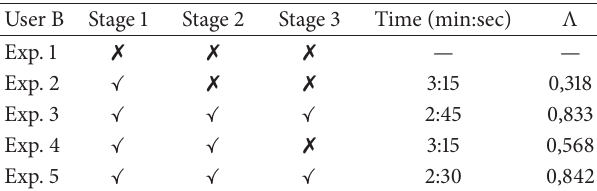
Table 2: Results of the experiment. User B.